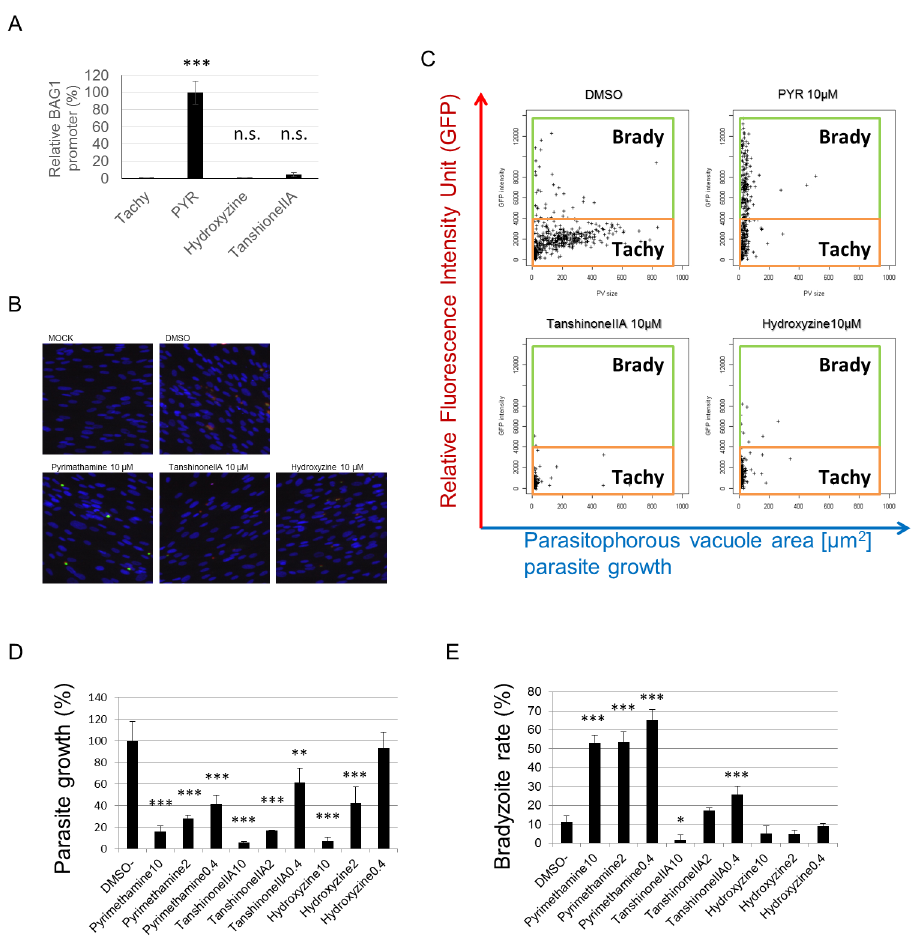
Fig 4. Bradyzoite-inducting effectsof tanshinone IIA and hydroxyzine compared with those of pyrimethamine. (A) PLK_DLUC_1C9 parasiteswere inoculatedonto a monolayer of HFF cellsand incubated for 24 h beforetest compounds (5 μ M pyrimethamine, 1 μ M hydroxyzine, 2.5 μ M tanshinoneIIA, or DMSO solventcontrol)were added.Infected cells weretreated with test compounds for 48 h and then relativeBAG1 promoter activity was calculated by dividingthe Firefly luciferaseactivity, expressed by the BAG1 promoter, by the Renillaluciferaseactivity, expressed by the TUB promoter. RelativeBAG1 promoter activity was compared with that of pyrimethamine-treated samplesas shown. Means ± SD are from triplicateexperiments. The statistical differencebetweenthe DMSO solventcontrol group (tachyzoite) and each compound was evaluated by usingDunnett’s test, *** p < 0.001. (B–E) To evaluatethe effects of the test compoundson spontaneously differentiated bradyzoites, Pru Δ ku80 Δ hxgprt were inoculatedinto host HFF cells with the compounds. At 48 h post infection, the infectedhost cells werefixed and stained with an anti- Toxoplasma mouseantibody and an anti-GFP antibody and 25 imageswere taken for each wellby automated fluorescence microscopy. Representative imagesof the DMSO-, 10 μ M pyrimethamine-, tanshinoneIIA-, and hydroxyzine-treated wells are shownin (B). Each parasitophorous vacuole(PV), whichwas detected by the anti-Toxoplasmaantibody, was quantifiedby size and GFP intensity. (C) Dot plots of the detected PV profilesfor the DMSO, 10 μ M pyrimethamine, tanshinoneIIA, and hydroxyzinegroups. To determinefor the rate of bradyzoiteinduction,a threshold valueof 4000 for the relativefluorescent units was set, as indicatedin (C). Means ± SD from three wellsfor each group werecalculatedfor the total PV size in the 25 images(parasitegrowth)(D) and GFP- positivePV rate (E). The statistical differencebetween the DMSO controland each compoundwas evaluated by usingDunnett’s test. * p < 0.05, ** p < 0.01 and *** p < 0.001.